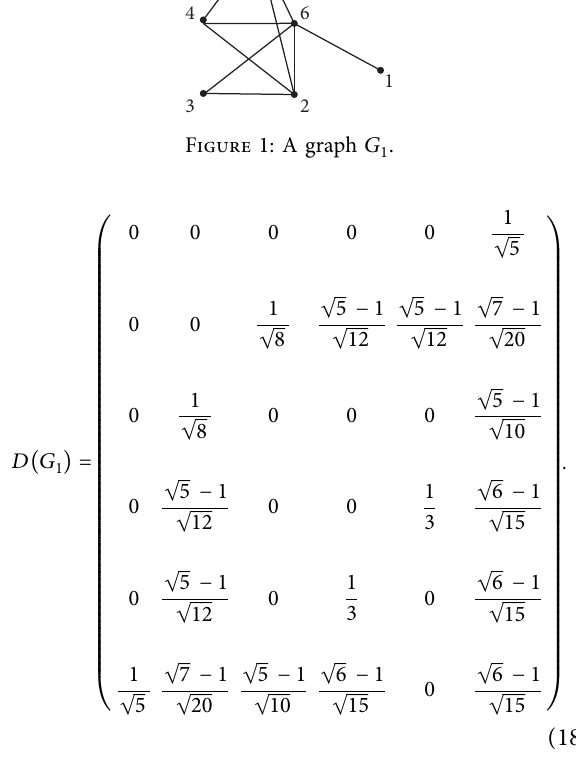
Figure 1: A graph G